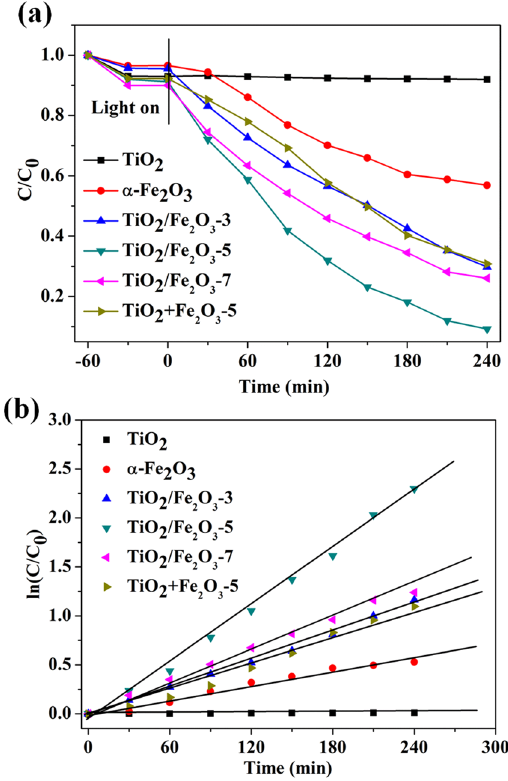
Figure 5. ( a ) Photocatalytic denitrogenation of pyridine over TiO 2 , α -Fe 2 O 3 and TiO 2 /Fe 2 O 3 composites with different mass ratios of Fe 2 O 3 ; ( b ) The pseudo-first order rate constants of pyridine photocatalytic denitrogenation over TiO 2 , α -Fe 2 O 3 and TiO 2 /Fe 2 O 3 with different mass ratios of Fe 2 O 3 . Reaction conditions: 40 mg of photocatalyst, 40 mL of 100 μ g/g